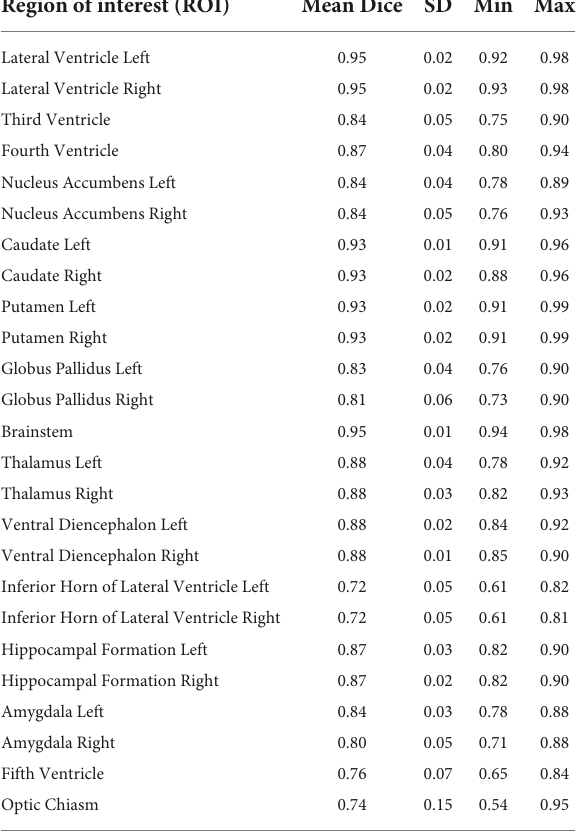
TABLE 2A Inter-rater reliability.